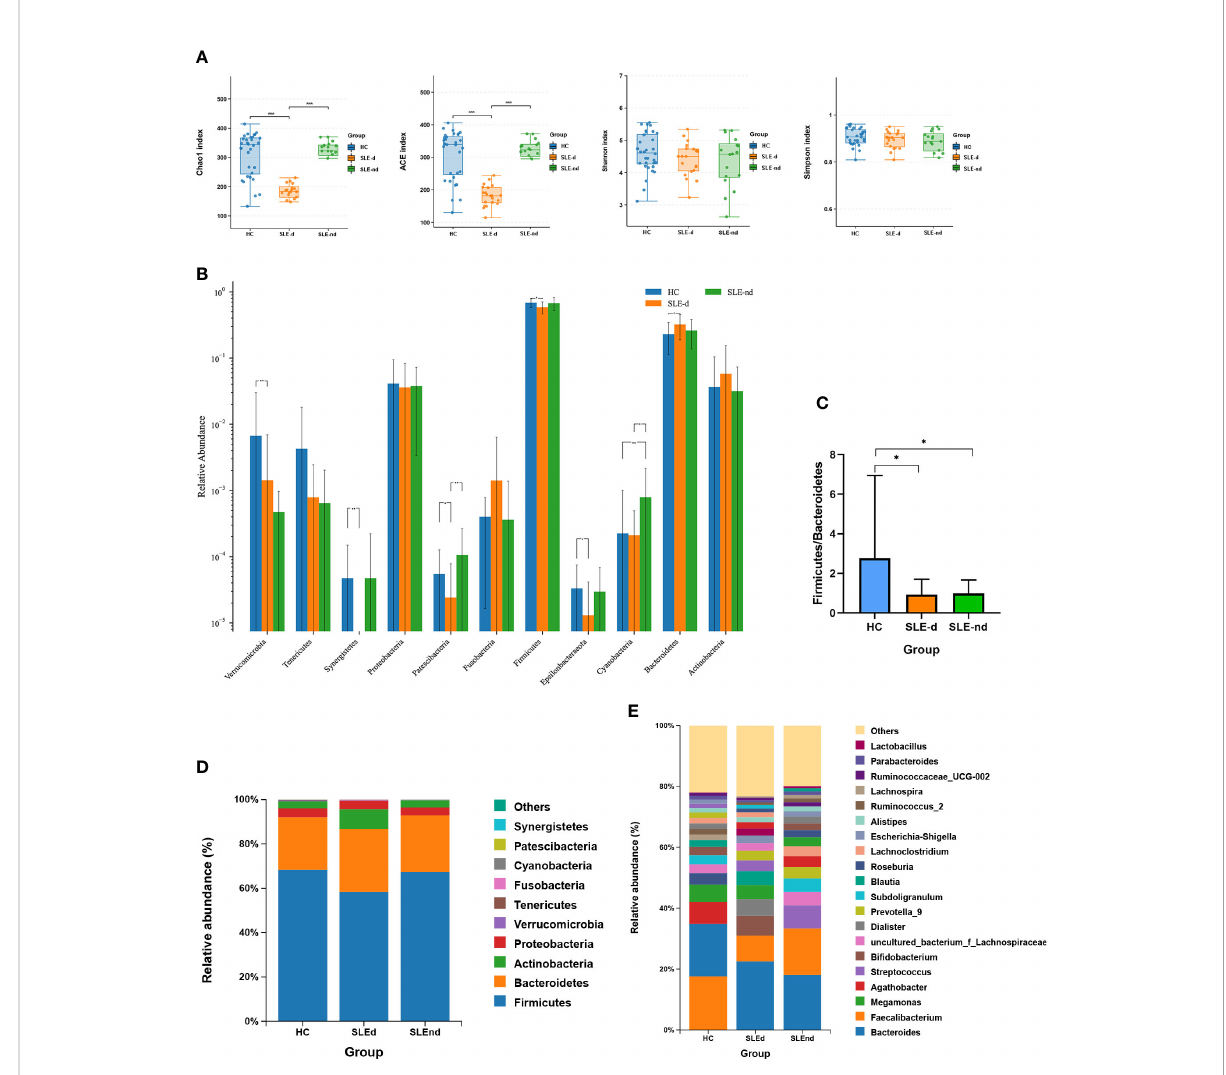
FIGURE 1 Microbial structures of the three groups. (A) Ace, Chao, Shannon, and Simpson indexes of the different groups, ***P < 0.001. (B) Signi fi cant differences in bacteria in phylum levels among the three groups, *P < 0.05, **P < 0.01. (C) Comparison of the three groups of Firmicutes/ Bacteroides phylum ratios, *P < 0.05. (D) Relative abundance of gut microbes at phylum levels in the three groups. (E) Relative abundance of gut microbes at the genus